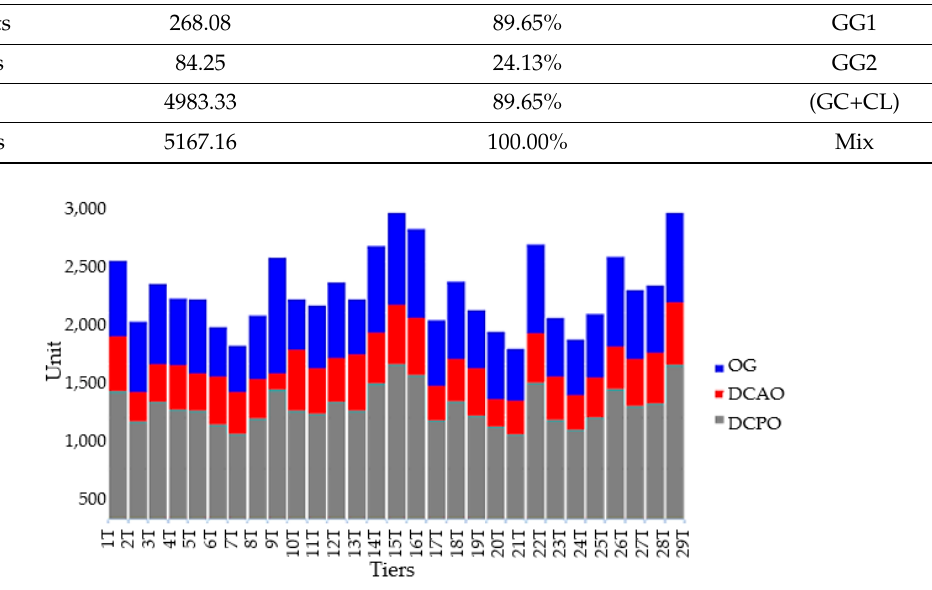
Figure 14. Stacked columns of DCAO , DCBO and OG.